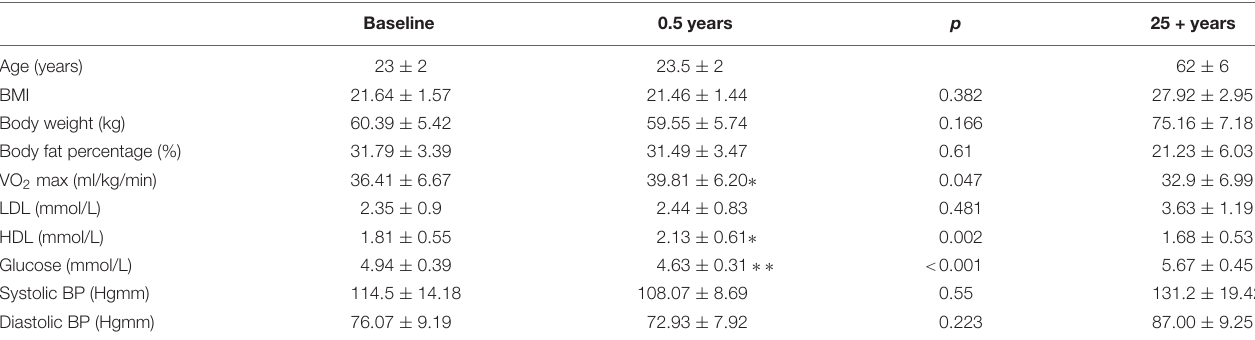
TABLE 1 | Subject